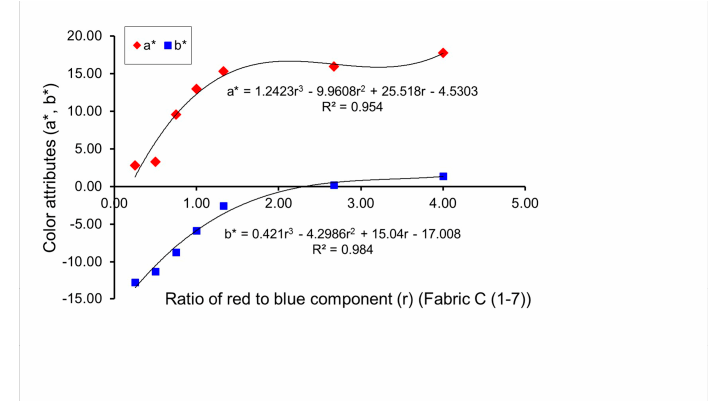
Figure 3. Effect of proportion of blue-red weft yarns on mixed color attributes ( a * and b *) of fabrics with a regulating